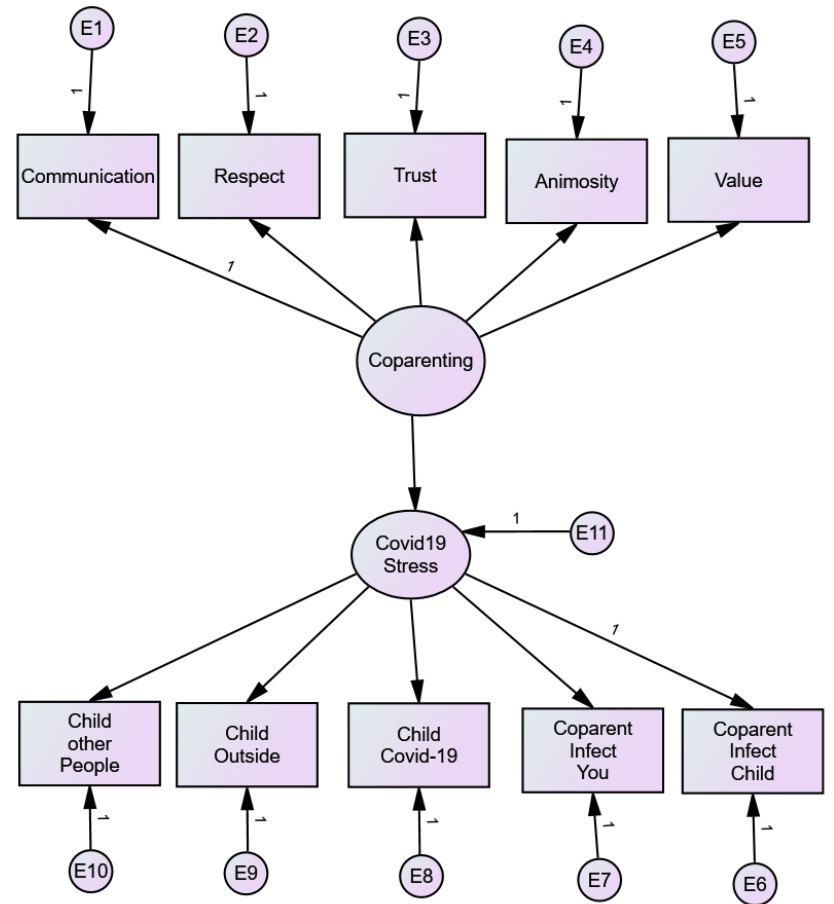
Figure 1. The study’s model.